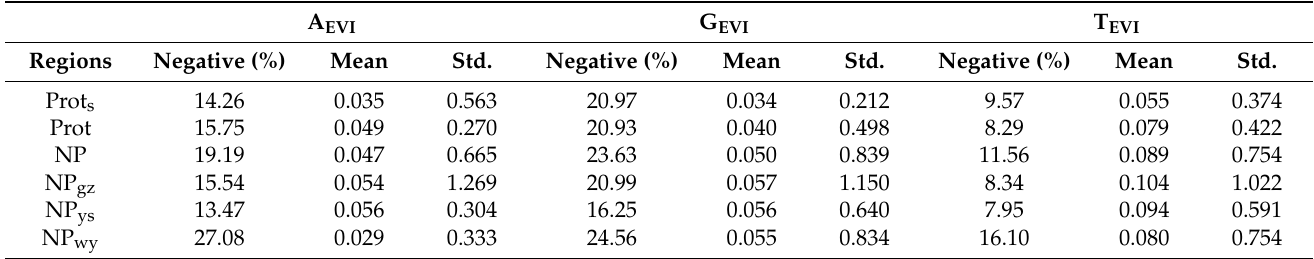
Table 5. The mean and negative percentages of abrupt, gradual, and total EVI changes. A EVI G EVI T EVI